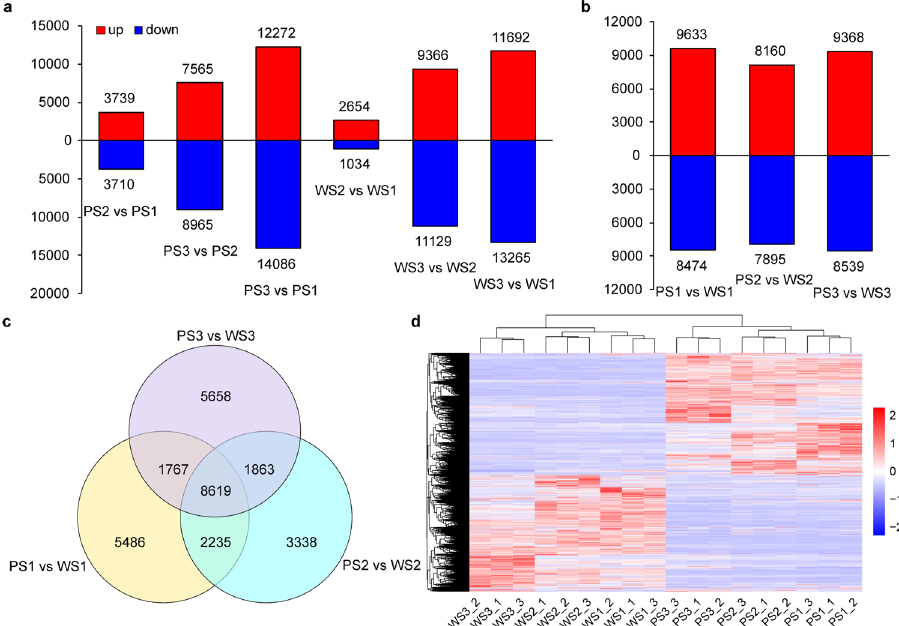
Figure 3. Characterization of differential gene expression in Xinxun 2 compared with YXA-5 at three developmental stages of the lavender spike. ( a ) The number of upregulated (upper bars) and downregulated (lower bars) genes at three stages of flowering in Xinxun 2 and YXA-5 cultivars, respectively. ( b) Comparison of upregulated and downregulated genes at three stages of flowering between two L. angustifolia cultivars. ( c ) Venn diagram displaying the number of DEGs in each comparison between two cultivars. ( d ) Expression profiles and cluster analysis of DEGs at three developmental stages in L. angustifolia spikes in two cultivars. PS1, PS2, and PS3 indicate the purple lavender flowers at Bud I, Bud II, and flowering stage 50%, respectively. WS1, WS2, and WS3 indicate the white lavender flowers at Bud I, Bud II, and flowering stage 50%, respectively, and 1, 2, and 3 represent three independent biological